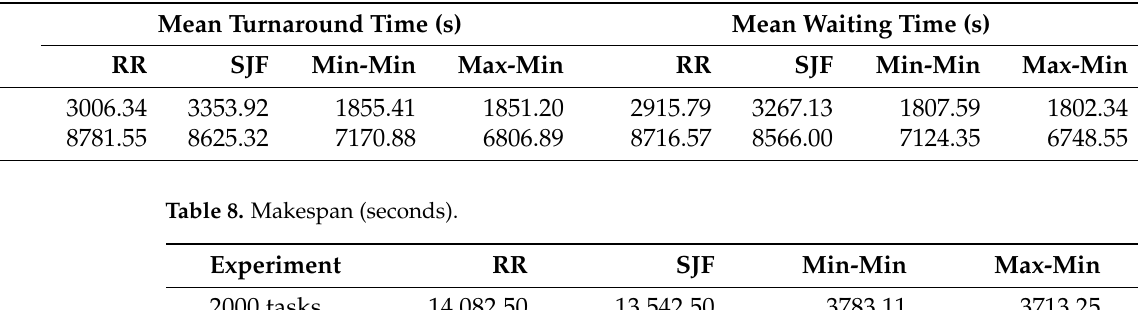
Table 7. Mean turnaround and waiting time